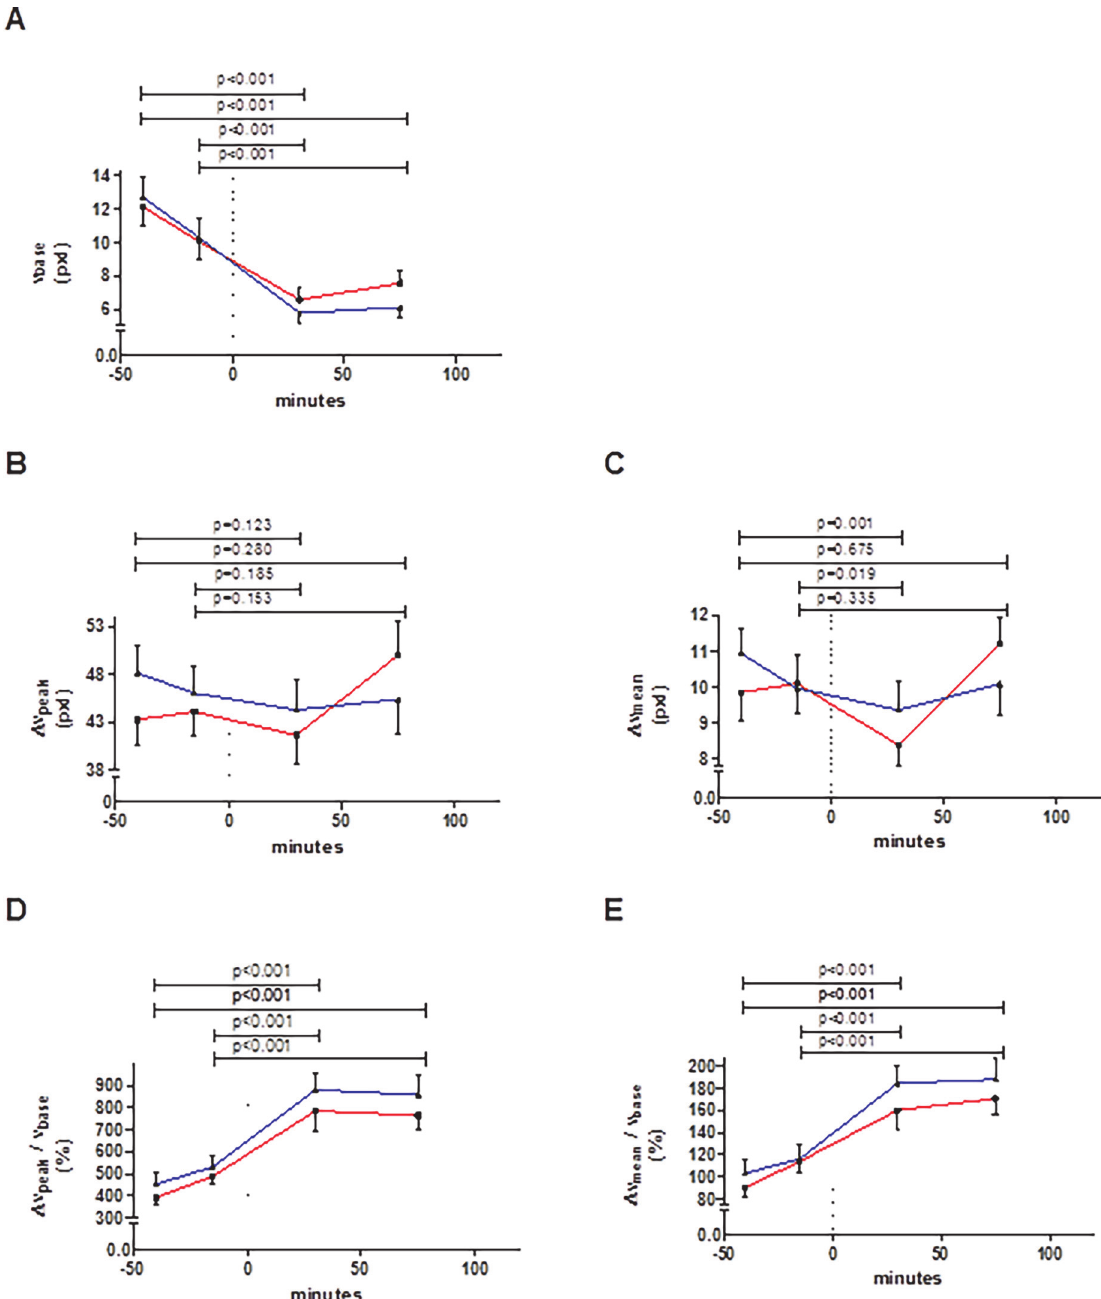
Figure 4. Changes in the baseline blood flow velocity (A), and the absolute changes in peak (B) and mean (C) blood flow velocity and relative changes in peak (D) and mean (E) blood flow velocity with glucose loading, as observed during flow-mediated dilation assessments at the 4 time- points indicated. Glucose was ingested at time-point 0 minutes (dashed vertical line). Red line: session 1, blue line: session 2; whiskers indicate standard error. Data did not differ between sessions at any corresponding time-point (all p-values (cid:3) 0.071, n = 22). The p-values on top of the graphs refer to differences between pre and post glucose intake (of the mean of both sessions). Abbreviations as defined in Table 1.